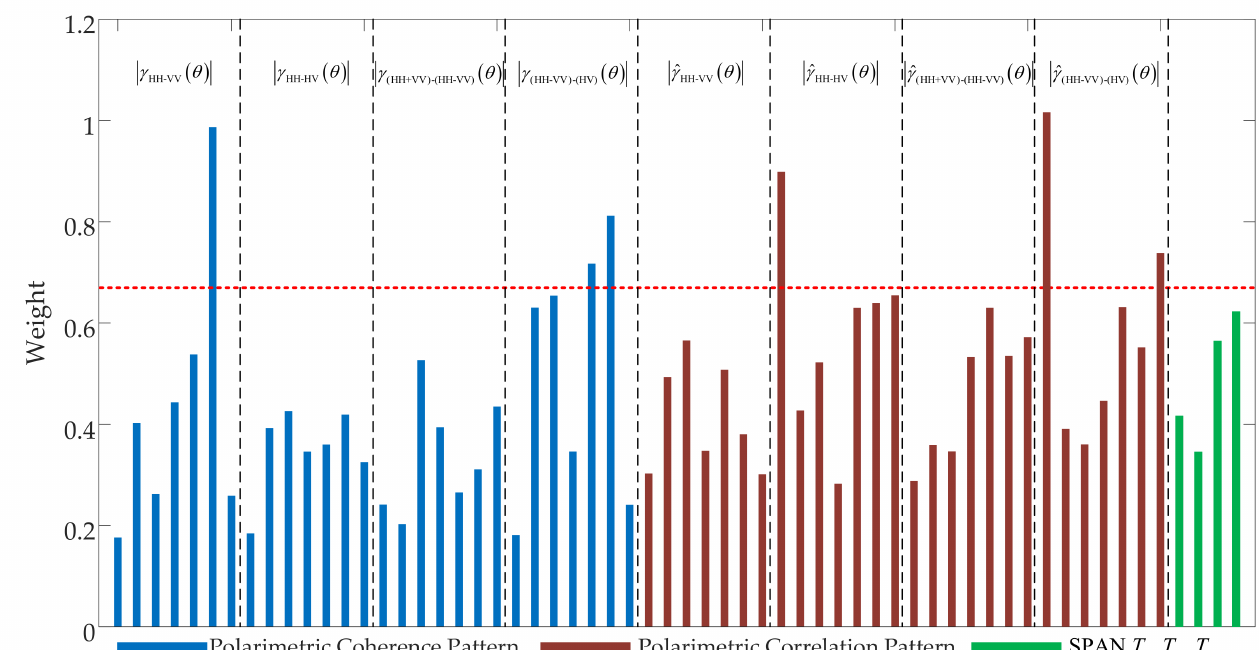
Figure 5. The weight of each feature from the GF-3 PolSAR dataset. From left to right are the weight of the original value, the standard deviation value, the contrast value, the anisotropy value, the mean value, the maximum value, and the minimum value in each group,